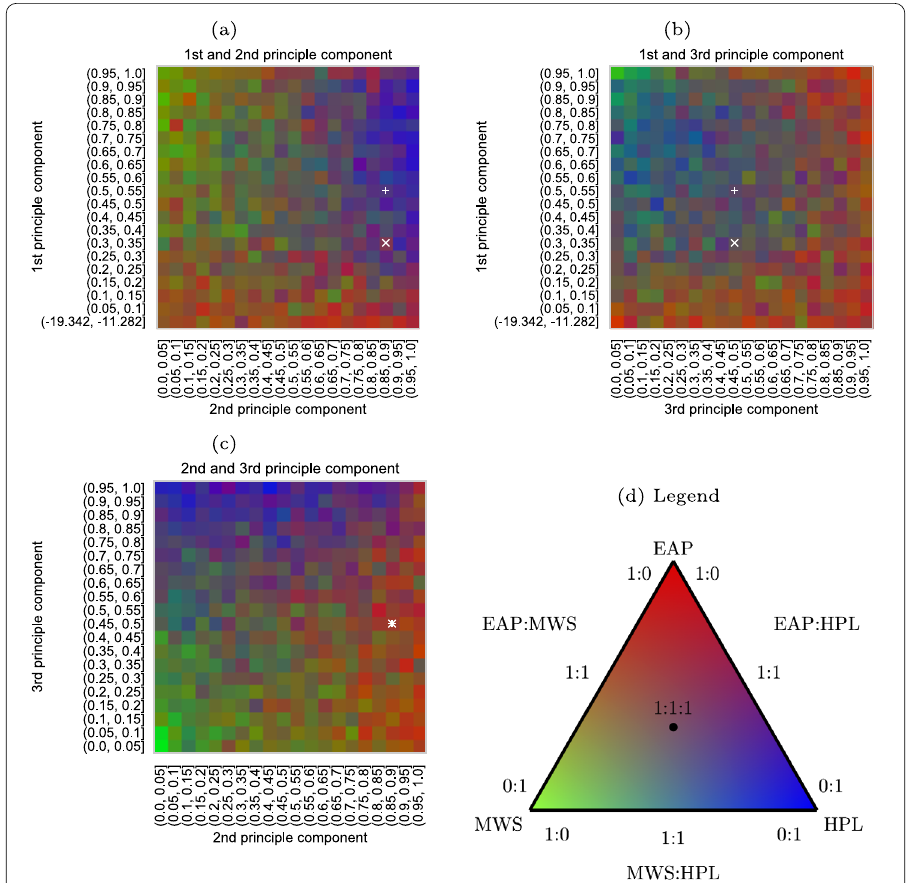
Figure 4 Discrimination maps for the first three principle components derived from statistically significant language time series features. The principle components were calculated from all 19,579 sentences. The figures also indicate the location of two example sentences: Sample id13843 (white cross symbol) was written by MWS (cf. p. 13). Sample id15671 (white plus symbol) was written by HPL (cf. p. 19). Both symbols are located in the same bin in panel ( c